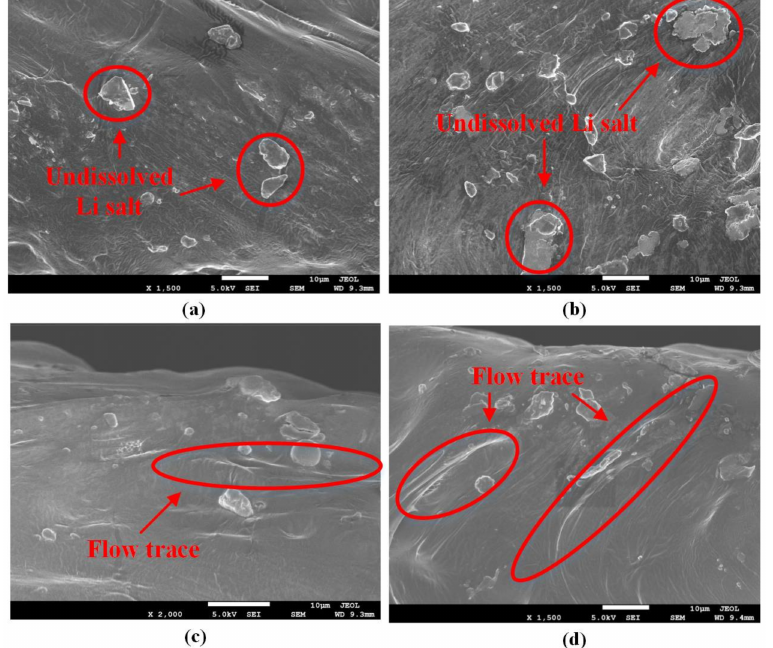
Figure 8. Surface morphologies of the electrolyte from: ( a ) prepared; ( b ) Reference Group; ( c ) Hot- pressed Group; ( d ) Ultrasonic Group.